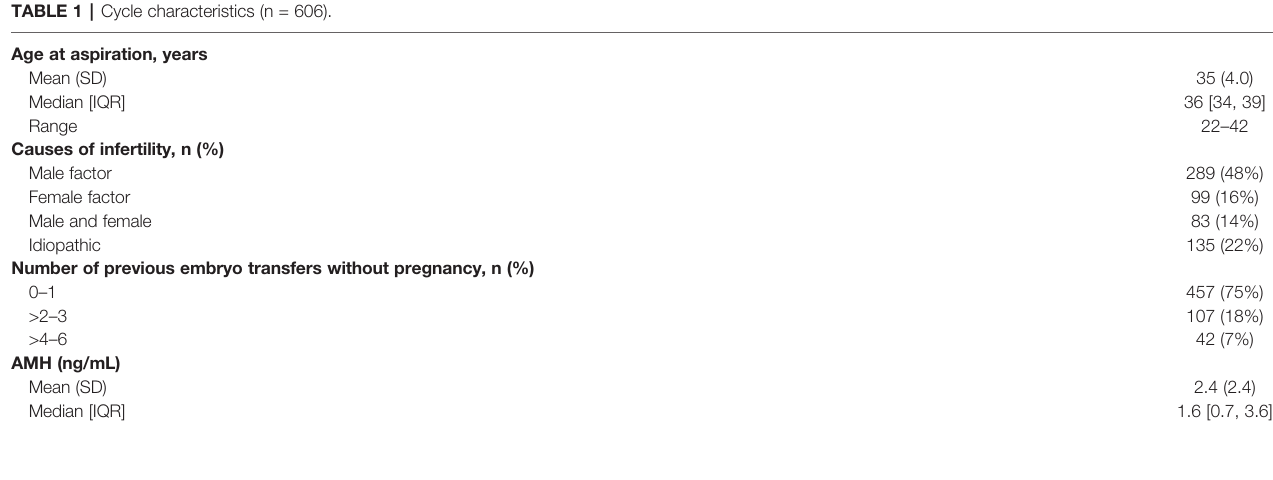
TABLE 1 | Cycle characteristics (n =